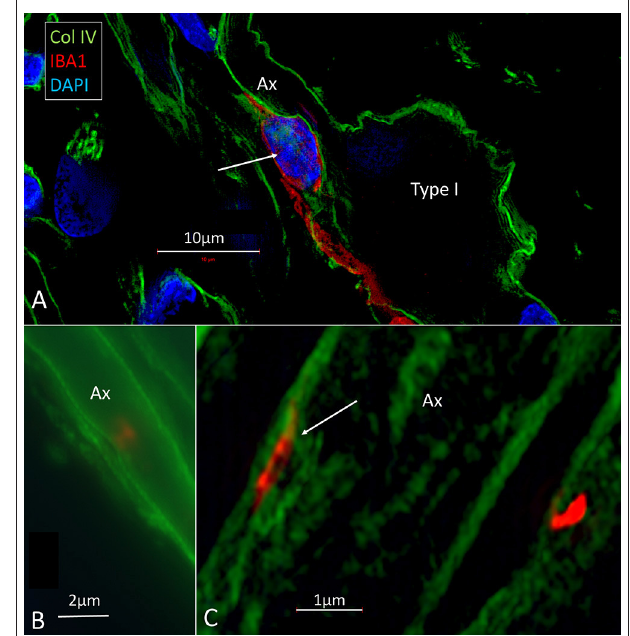
FIGURE 8 | (A) A macrophage (red)can be seen lying close to the spiral ganglion cell body. The macrophage cell nucleus also expresses IBA1. (B,C) Its cell processes extend along the axon and form contact points at the perineural